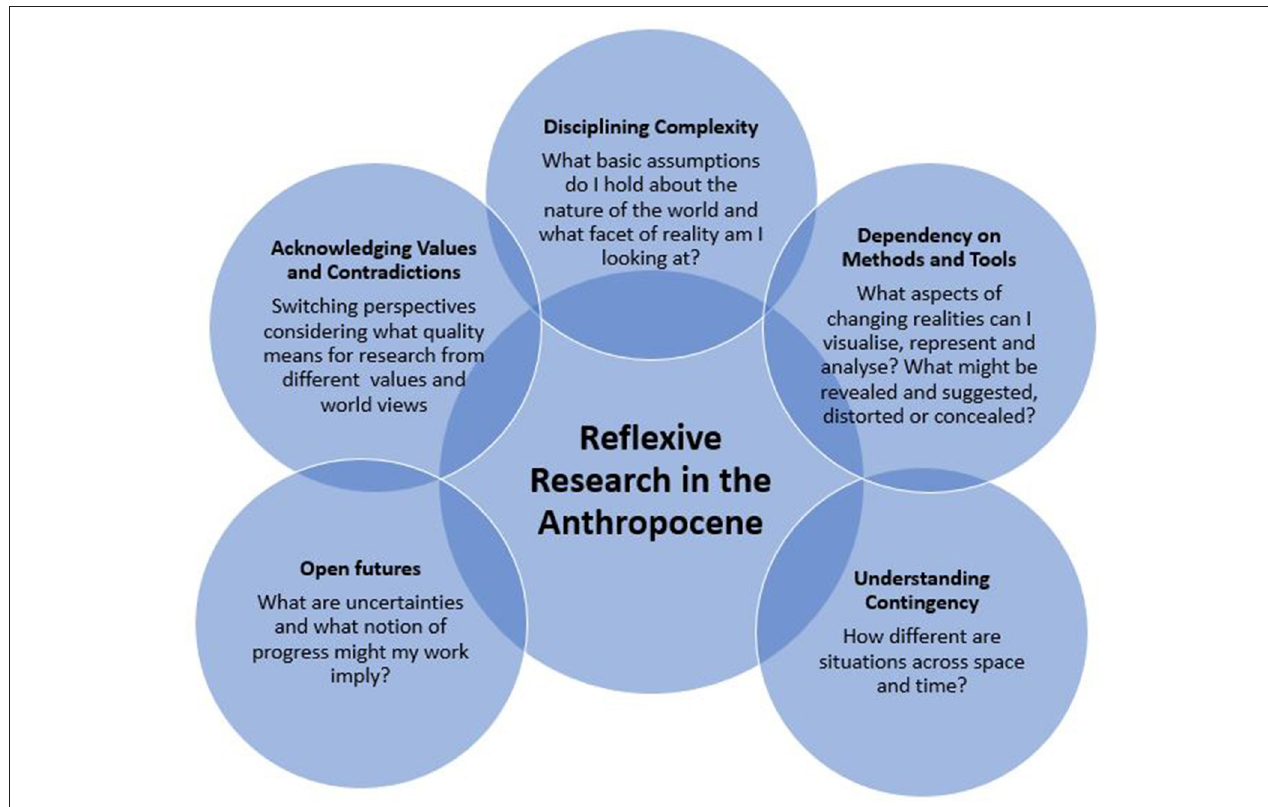
FIGURE 1 | Pedagogic framework of competences for reflexive research in pluralist societies. Scaffolding questions for participants to reflect on their research relating to each competence field: Acknowledging values and contradictions: What are the underlying assumptions about the nature of science/knowledge—and the role of the researcher in producing it? To what extent are you/ can you be “objective”? What is the overarching societal question you are interested in and your personal motivation/reasons/rationale for engaging with it? Do you know of others who might not agree and why? Disciplining complexity : Which facet of complex phenomena does my chosen discipline direct attention at? How might it relate to other facets/fields of knowledge? What is the main chosen discipline/research area and what are your core theories and concepts? What makes your field of research different from others? Why have you chosen it? What are your 3–5 main research questions? Please state your field’s underlying assumptions about the nature of actors, agency, system, and the relation between actors and the system, or the conception of the ability of actors to contribute to systemic change? Dependencies on methods and tools : What is your research methodology? Are you tri-angulating insights from several research methods? Which facets do your theoretical and methodological choices highlight, suggest, reveal? Which blind spots might you produce? What aspects might you distort or conceal with your methodological choices? Understanding contingency : In how far do you engage with abstract situations and concepts and models and with how many different situations do you test these? Open futures : What is the relation between your research and